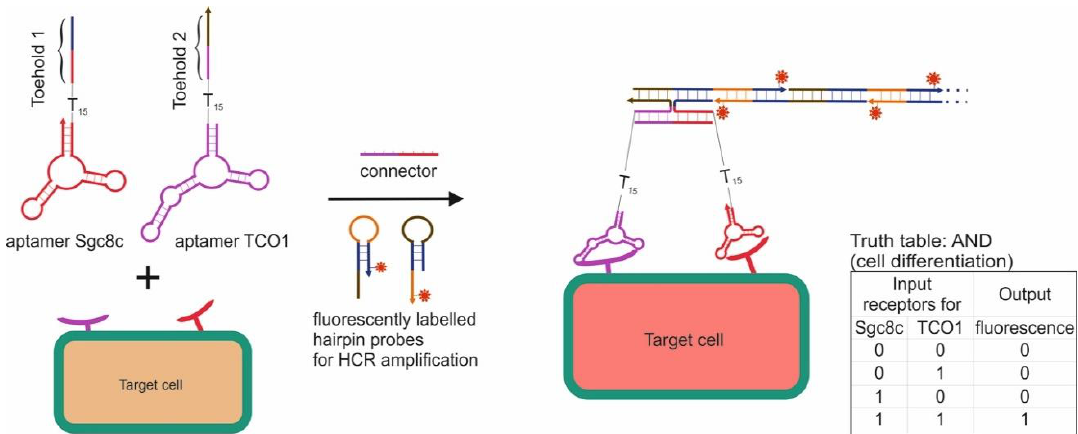
Figure 18. The AND logic gate. Adapted from Reference [35]. Copyright © 2020, American Chemical Society.